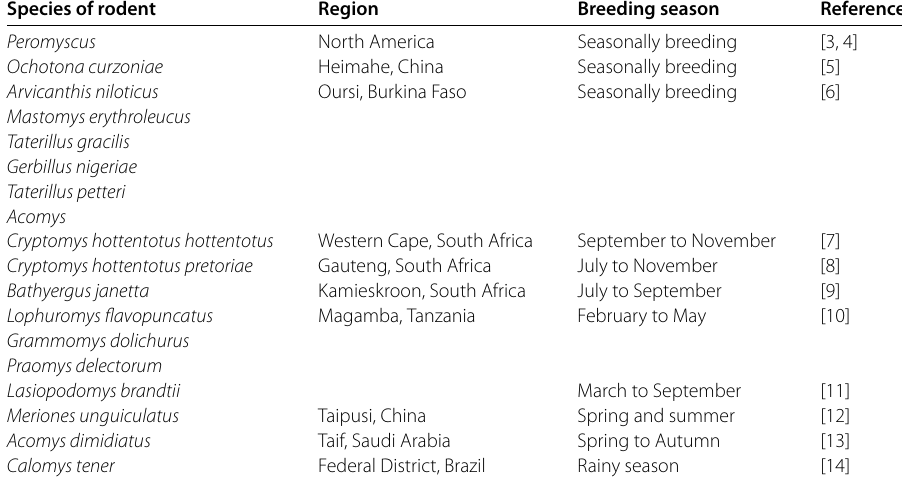
Table 1 Seasonally breeding rodent Species of rodent Region Breeding season